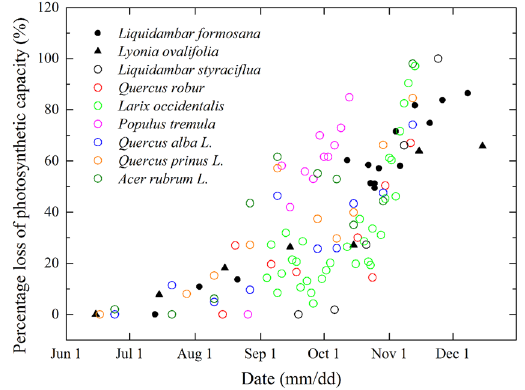
Figure 7. Percentage loss of photosynthetic capacity ( P nsat (light-saturated net photosynthetic rate) or P nmax ) of L . formosana and other subtropical (solid symbols) and temperate (open symbols) deciduous tree species for comparison. All data are percentage loss from the maximum P nsat in summer season. Data for Lyonia ovalifolia (monthly) are from Zhang et al . 9 , Liquidambar styraciflua from Herrick et al . 16 , Quercus robur from Morecroft et al . 36 , Larix occidentalis from Rosenthal et al . 37 , Populus tremula from Sun et al . 38 , Quercus alba L ., Quercus prinus L . and Acer rubrum L . from Wilson et al . 53